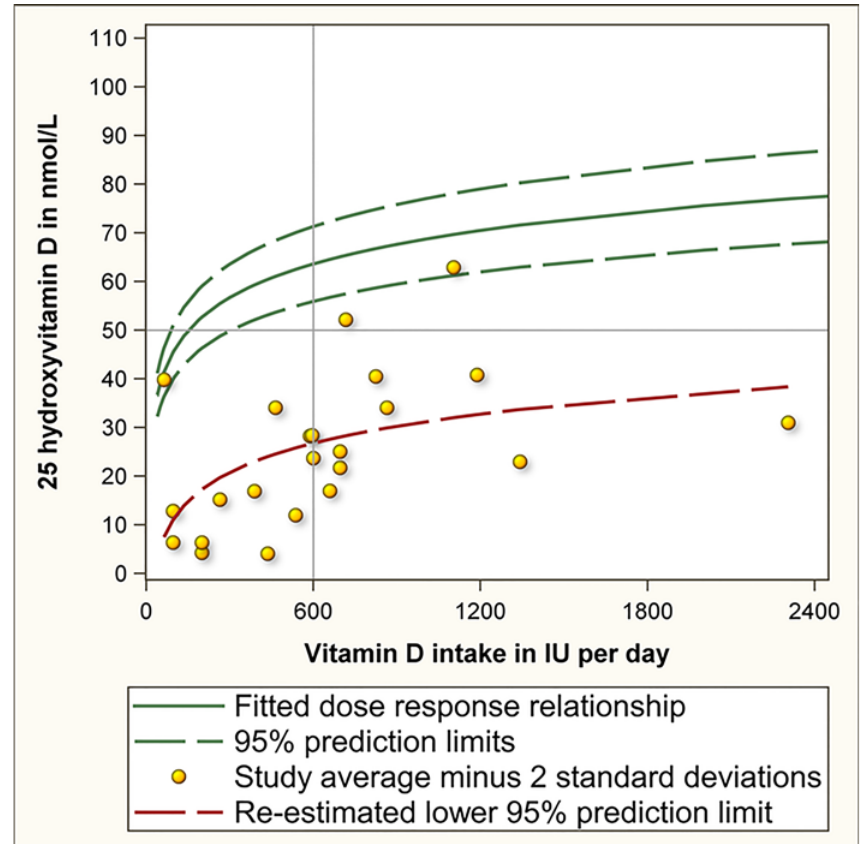
Figure 2. Dose response relationship of vitamin D intake and serum 25 hydroxyvitamin